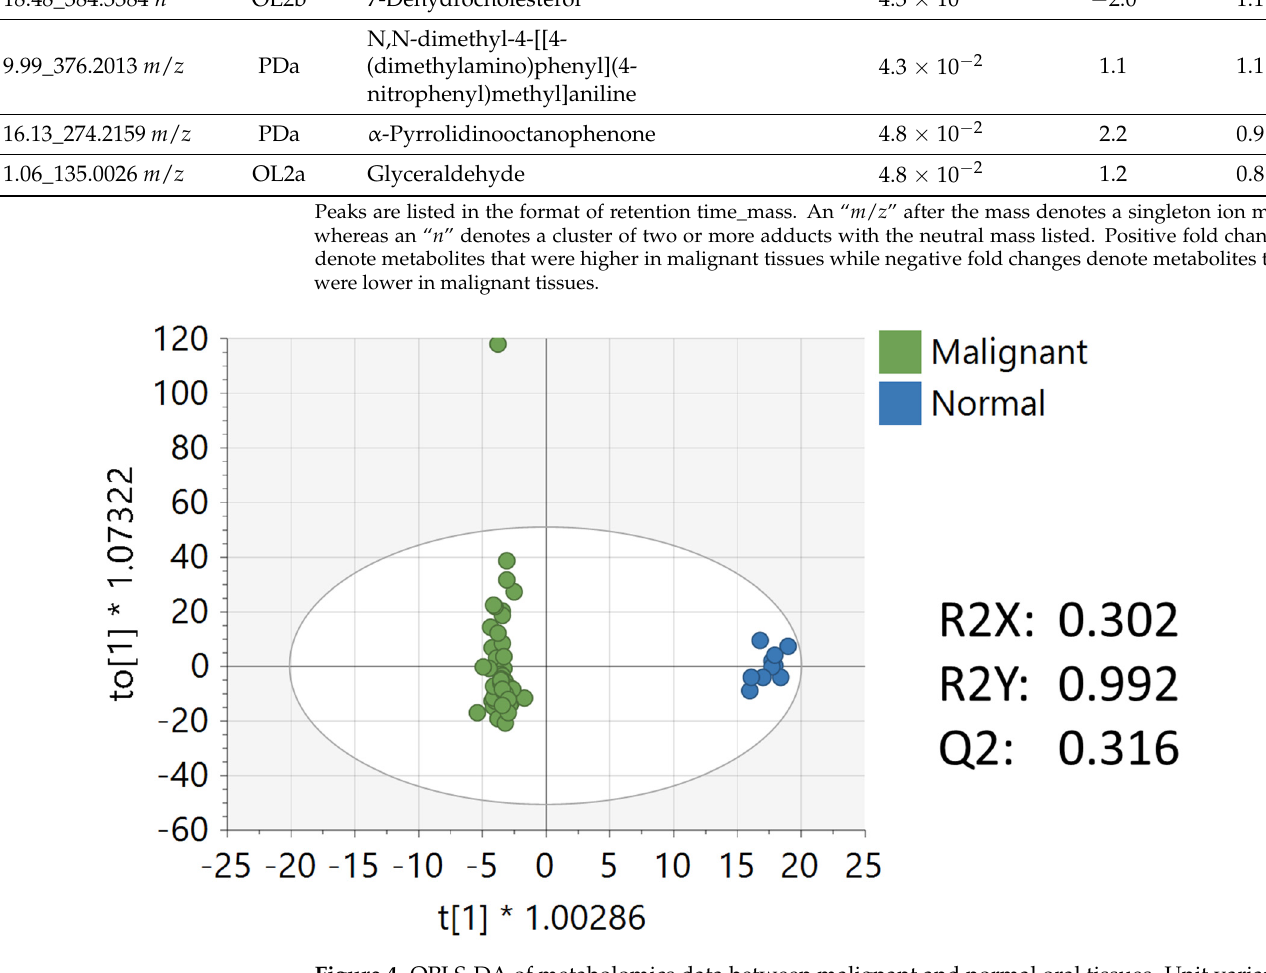
Figure 4. OPLS-DA of metabolomics data between malignant and normal oral tissues. Unit variance scaling was used for all peaks.